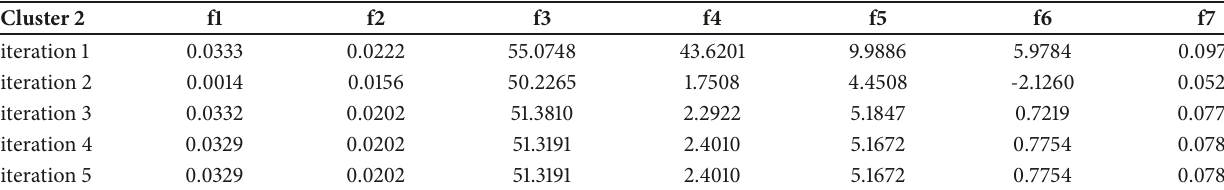
Table 9: Iterations for Cluster 2.